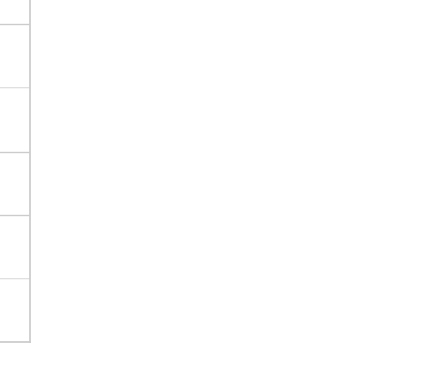
Figure 4. The classification accuracies of the NB model using the stratified five-fold cross-validation-1.